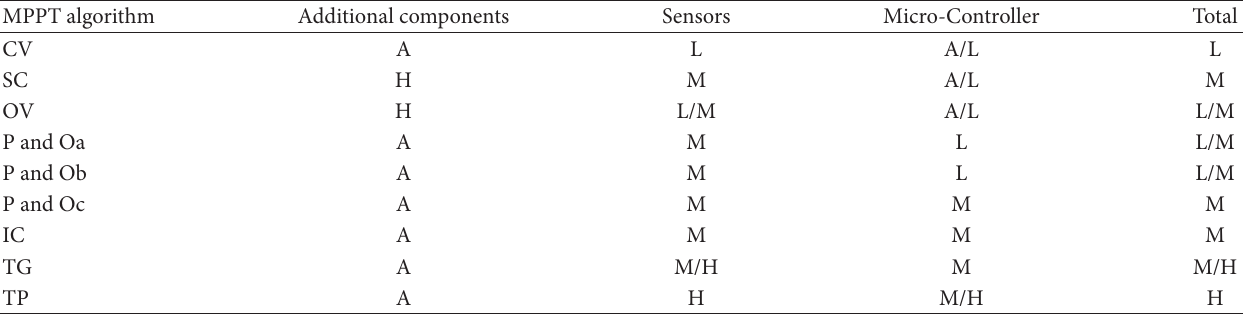
Table 1: MPPT methods comparison [12].